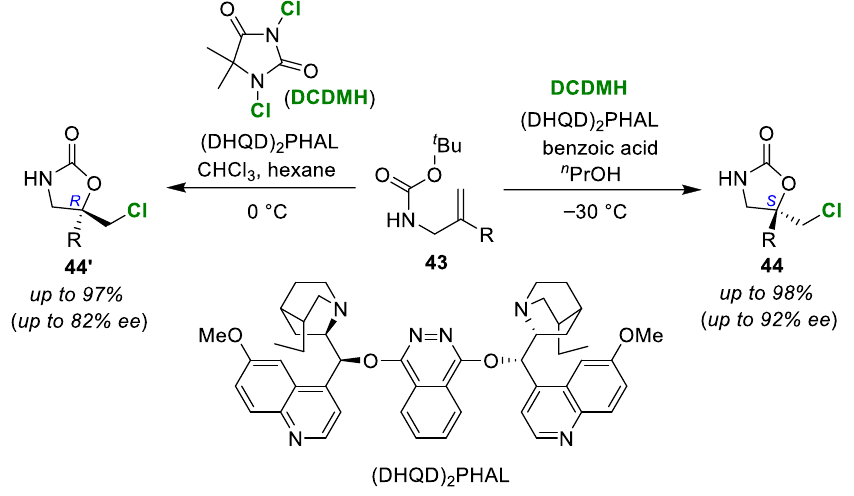
Figure 22. Solvent-dependent enantioselective chloro-cyclizations of olefinic carbamates 43 using (DHQD) 2 PHAL as an organocatalyst.